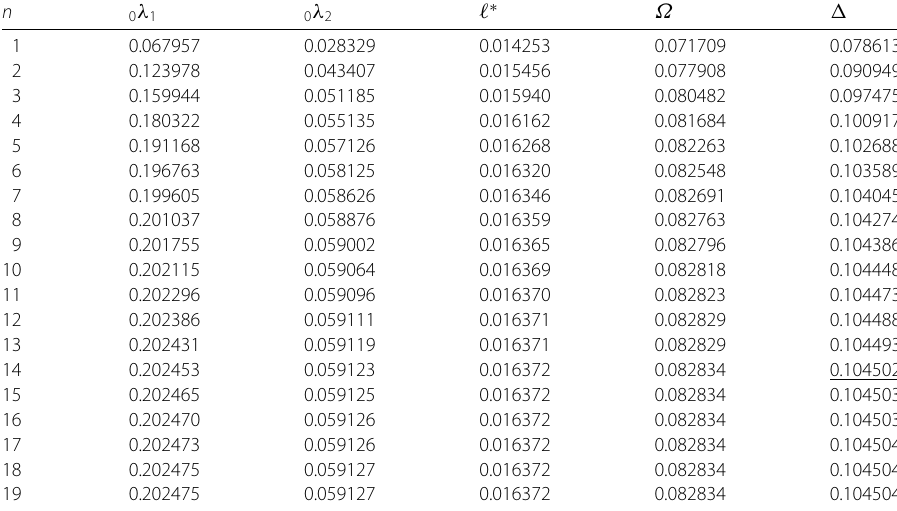
and n = 19 of Algorithm 6